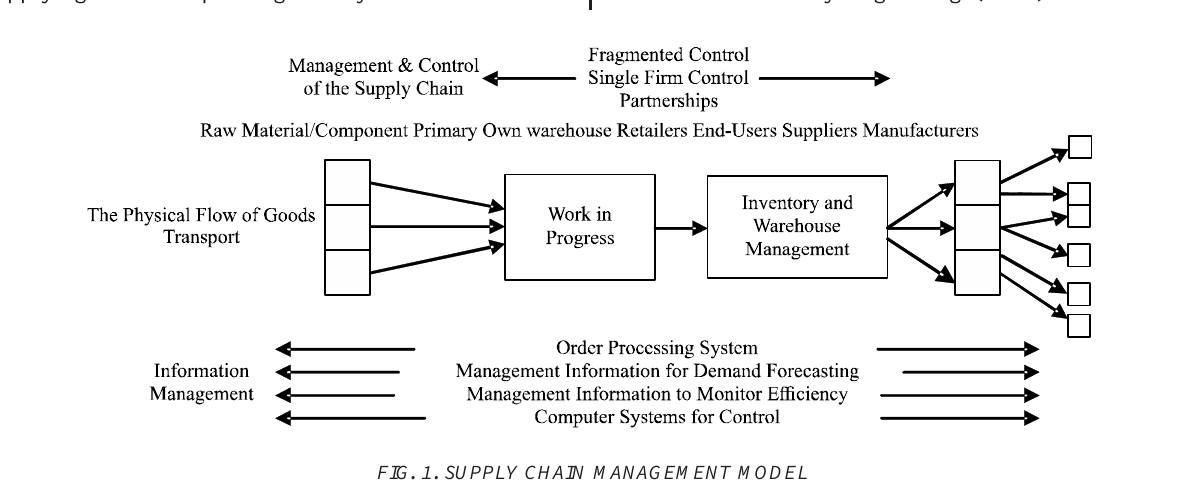
FIG. 1. SUPPLY CHAIN MANAGEMENT